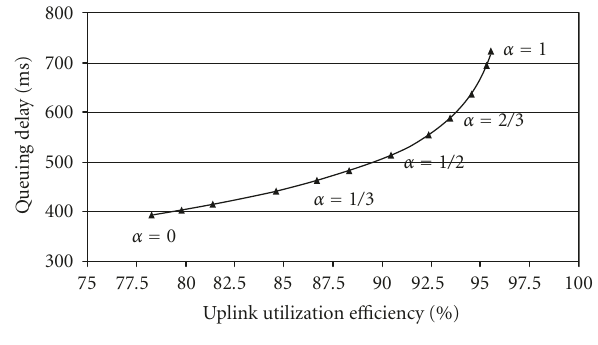
Figure 6: Delay versus e ffi